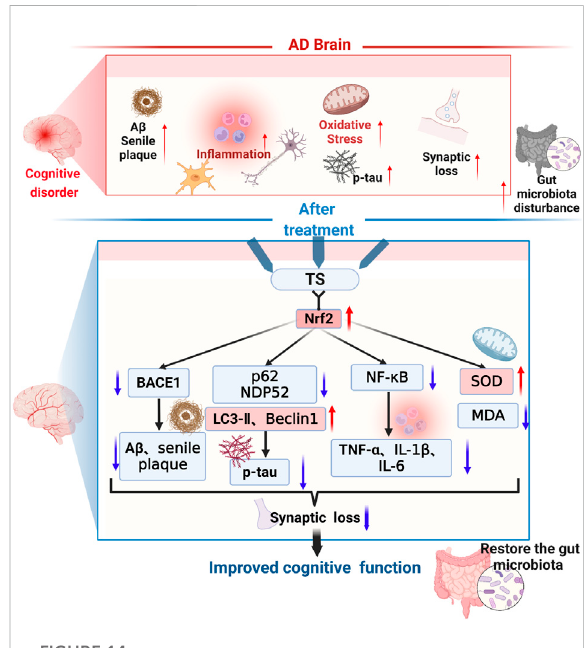
FIGURE 14 ThetherapeuticeffectsandrelatedmechanismsofTSagainst AD. The following pathological phenomena occur in the AD brain: (1) increased A β generation, aggregation and increased deposition of senile plaques; (2) enhanced activation of microglia and astrocytes, elevated in fl ammatory cytokines levels; (3) increased oxidative stress and decreased secretion of antioxidant stress factors; (4) increased synaptic loss; (5) aggravated gut mictobiota dysbiosis and increased the pathogenic bacteria. Finally, these pathological changes led to the cognitive dysfunction of the AD patients. TS treatment could improve cognitive function through multiple mechanisms. Firstly, TS regulated the transcription and expression of BACE1 via Nrf2, reduced the generation and aggregation of A β , thus inhibited the deposition of senile plaque. Secondly, TS downregulated the expression of p62 and NDP52 by promoting autophagy, upregulated the expression of LC3-II and Beclin-1, thus promoting the clearance of p- tau. Thirdly, TS downregulatedthe transcription andexpression ofNF- κ BviaNrf2, reducedthelevelsofin fl ammatorycytokines,thusamelioratedthe neuroin fl ammation. Fourthly, TS increased the level of SOD and reduced the level of MDA, alleviating oxidative stress. Eventually, TS ameliorated synapse loss and alleviated the gut microbiota dysbiosis. Red arrows represent upregulation and blue arrows represent downregulation. AD, Alzheimer ’ s disease; TS,